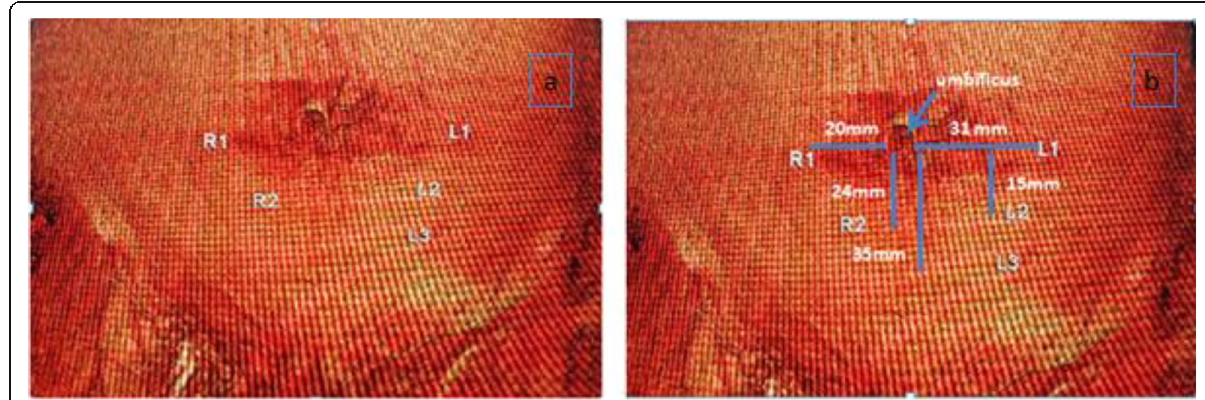
Fig. 4 Coronal volume-rendered (VR) images of the anterior abdominal wall showing the mapping of the deep inferior epigastric artery perforators ( a ) and their site in relation to the umbilicus ( b )